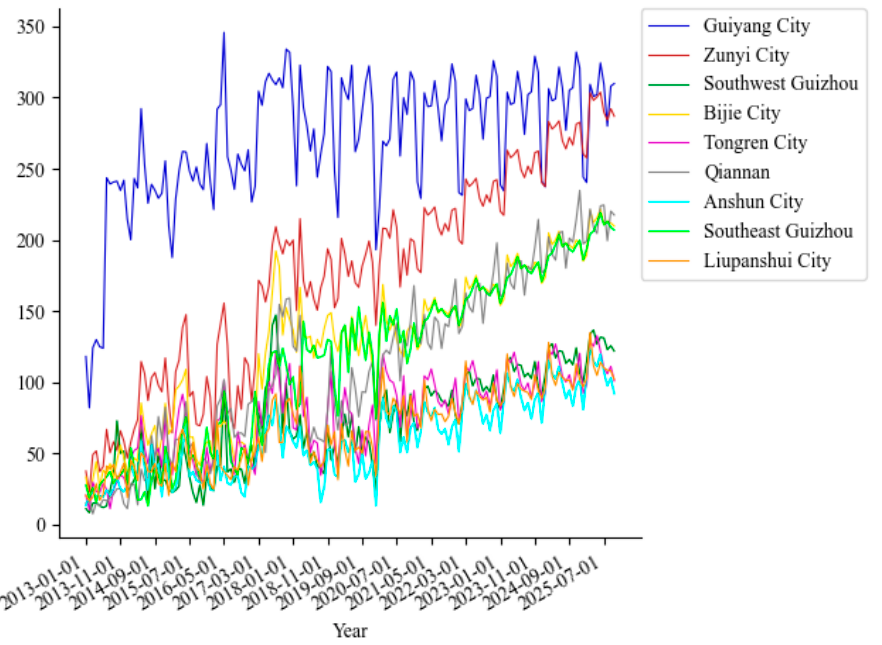
Figure 9. Forecast trend of “AI + education” attention in the cities (prefectures) of Guizhou province.